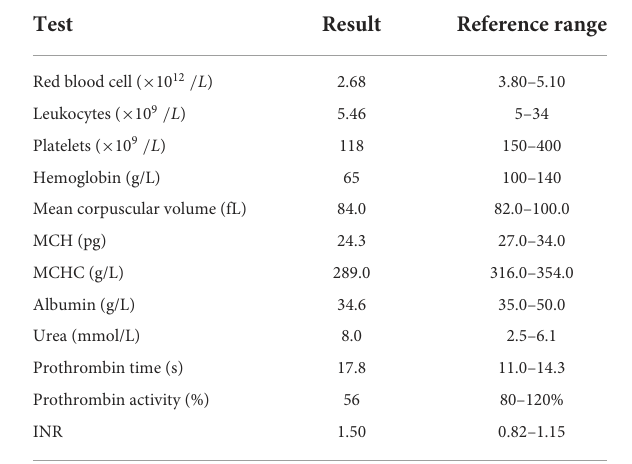
TABLE 1 Laboratory findings before